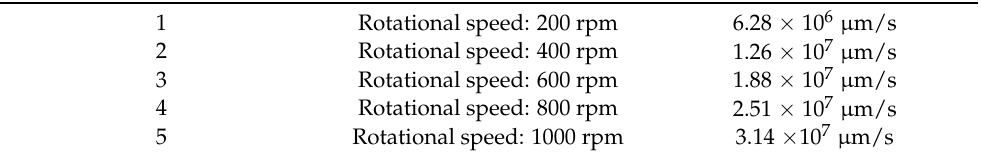
Table 3. Speed of the particle in the